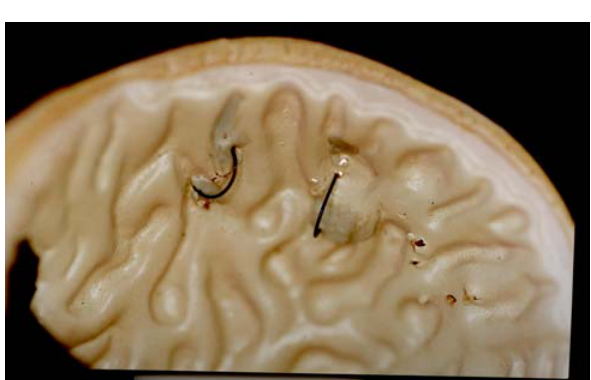
FIGURE 5 - Schematic view: folded thread is pulled into PDA with SA